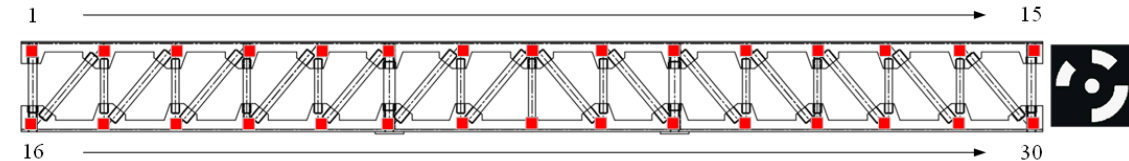
Figure 8. Layout diagram of test beam’s code marks.